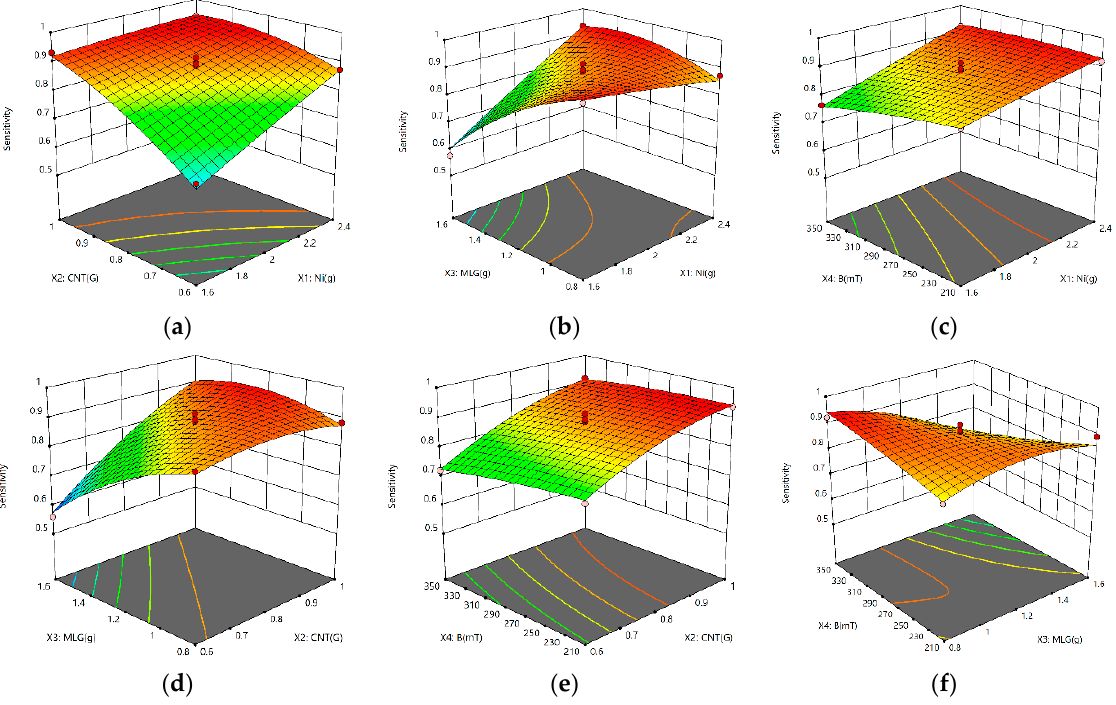
Figure 9. 3D response surface plots. ( a ) Interaction between the MWCNT and Ni content; ( b ) interaction between the MLG and Ni content; ( c ) interaction between magnetic field intensity (B) and Ni content; ( d ) interaction between MLG and MWCNT content; ( e ) interaction between MWCNT content and B; ( f ) interaction between MLG content and B.